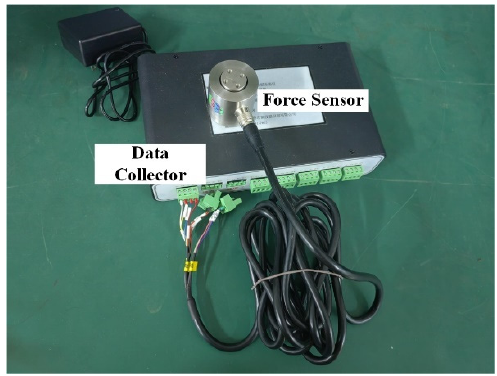
Figure 16. The 3D force sensor data measurement system.